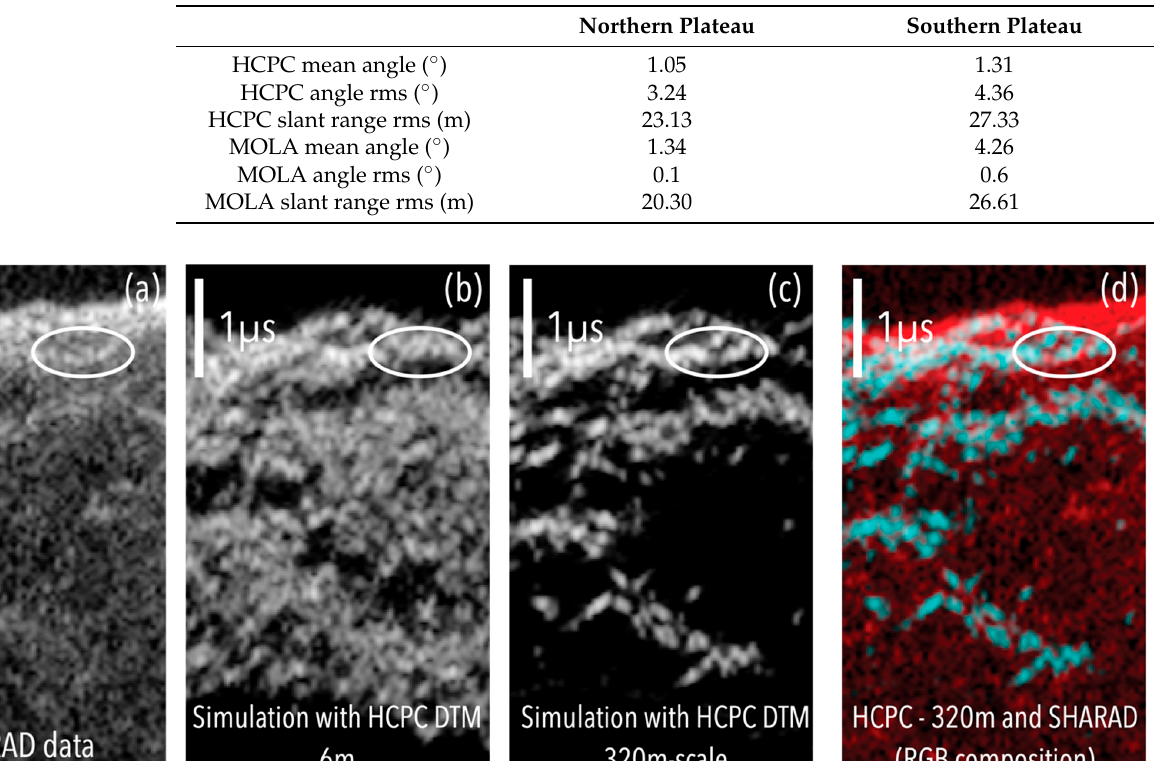
Figure 14. Comparison between a 18 km portion of the SHARAD dataset n°5128501 ( a ) and simula- tions using the corrected DTM with photoclinometry. The simulation in ( b ) was performed with the original DTM refined by photoclinometry at 6m. We do not see the surface on the simulated radar- grams due to the DTM not covering the nadir part of the trajectory. ( c ) Wavelet-transformed DTM filtered at 320 m. ( d ) RGB composition with the SHARAD radargram on the red channel, and the simulation using the filtered DTM refined by photoclinometry on the cyan channel. The reflector that we are looking for is circled in white.